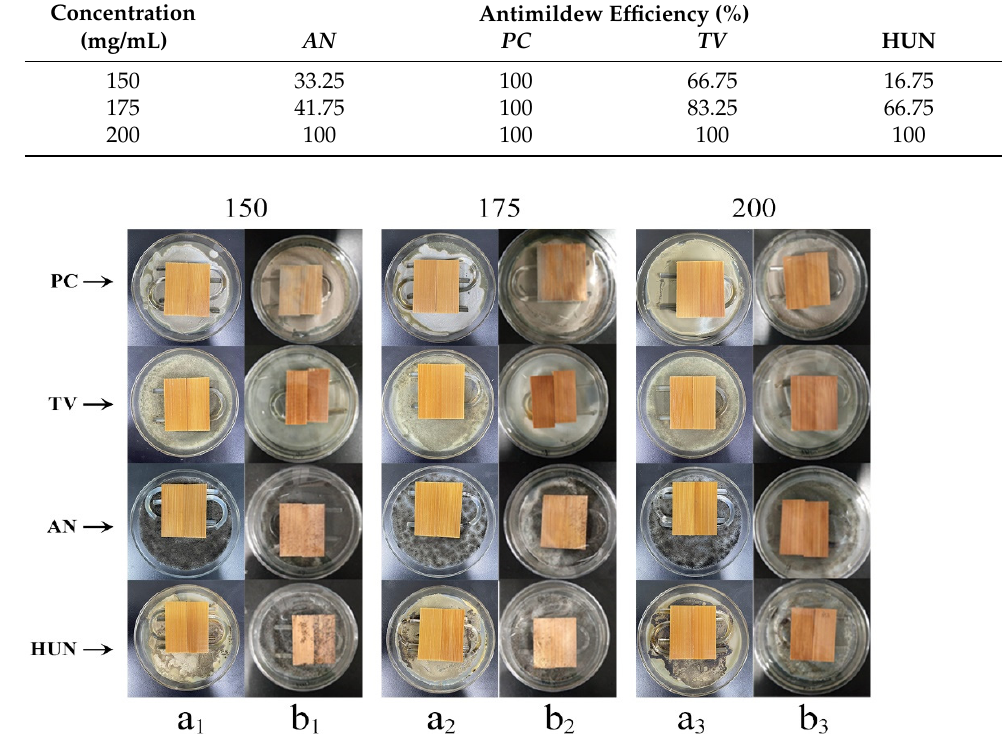
Figure 8. Comparison of the antimildew effect of different concentrations of tea-polyphenol-modified citral and citral antimildew treatment on bamboo. ( a 1 ): 150 mg/mL tea-polyphenol citral treated bamboo, ( a 2 ): 175 mg/mL tea-polyphenol citral treated bamboo, ( a 3 ): 200 mg/mL tea-polyphenol citral treated bamboo; ( b 1 ): 150 mg/mL citral treated bamboo, ( b 2 ): 175 mg/mL citral treated bamboo, ( b 3 ): 200 mg/mL citral treated bamboo.